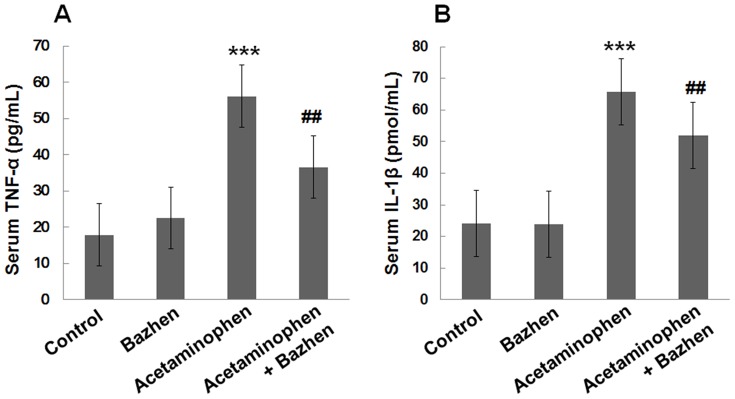
Effect of Bazhen decoction on serum TNF-α and IL-1β levels in acetaminophen intoxicated mice.(A) TNF-α and (B) IL-1β. Values are expressed as means ± SD of 12 animals in each group. Significance difference were ***p<0.001 as compared with the control; ##
p<0.01 as compared with acetaminophen group.